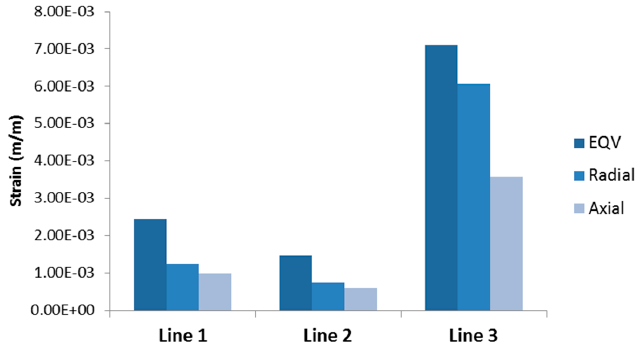
Figure 11. Maximum strains at peak expiration (0.5 s). Von Mises strain in Section 3 is 4.89 times